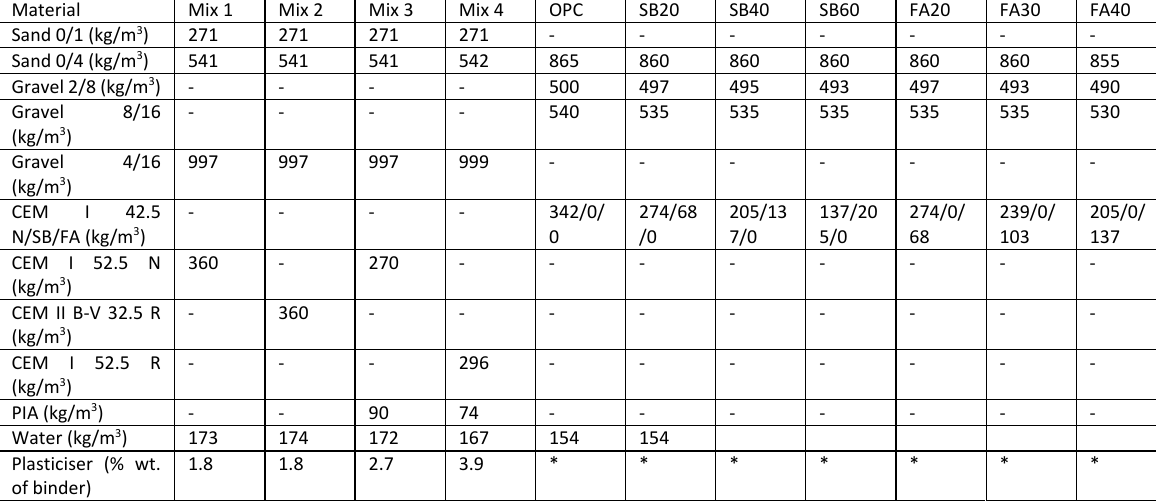
Table 1 . Composition of the studied concrete mixes . Material